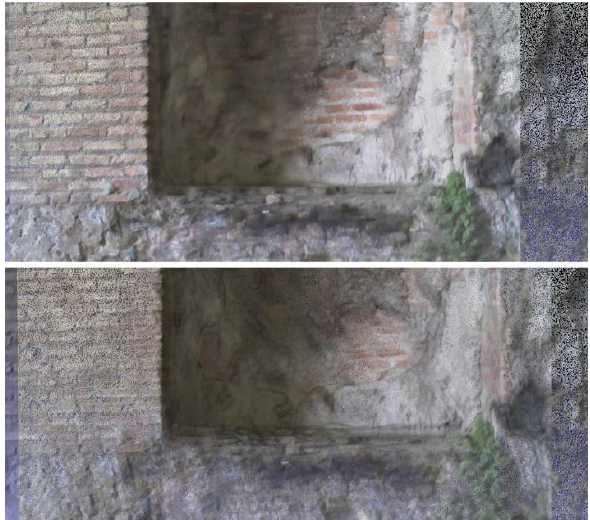
Figure 8. Top: RGB camera rendered on the point cloud in its original position. Down: RGB camera rendered on the point cloud after the 4cm down translation